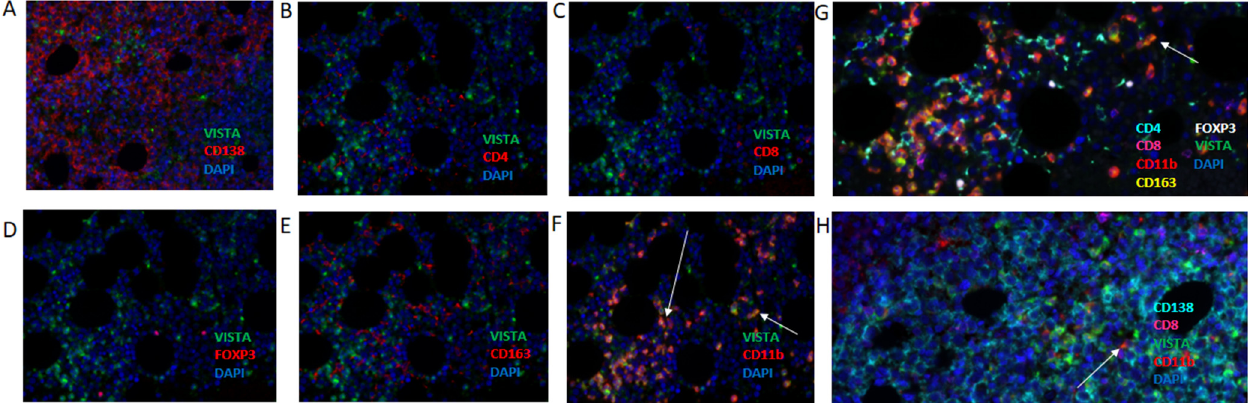
Figure 3. In MM, VISTA is expressed by CD11b+ cells, but not CD138+ cells, CD4+, CD8+, FOXP3 lymphocytes nor CD163+ macrophages. Multiplex immunofluorescence using bone marrow trephine slides with VISTA and CD138 ( A ); CD4 ( B ); CD8 ( C ); FOXP3 ( D ); CD163 ( E ); and CD11b ( F ). Co-expression of VISTA and each of these markers, only observed in case of CD11b, is indicated with arrows pointing at orange cells. ( G ) Multiplex showing combined stainings for CD138, CD11b, CD8, VISTA and DAPI. ( H ) Multiplex showing combined stainings for CD138, CD8, VISTA, CD11b and DAPI.